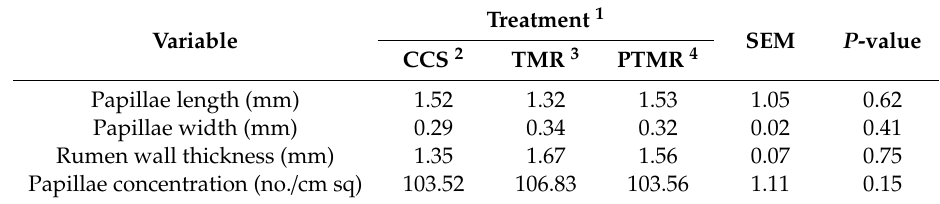
Table 6. Means of rumen developments measures of sacrificed crossbred male calves fed CCS, TMR, and PTMR.